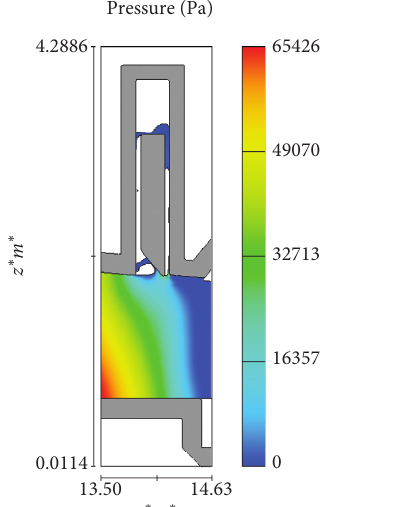
Figure 24: Flow pattern around the stiffener and no flow sepa- ration in this area (100% valve opening).